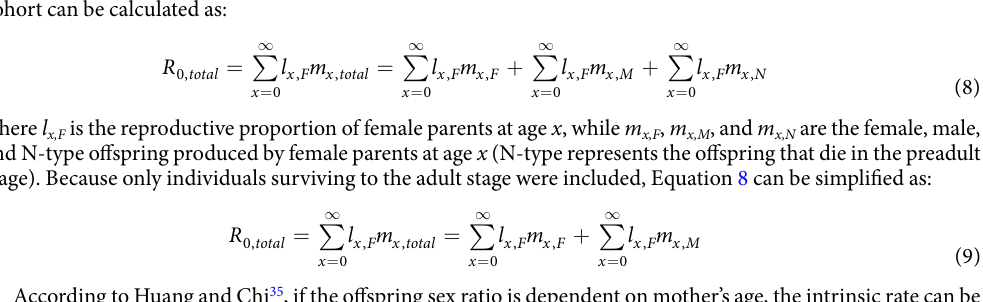
In arrhenotokous reproduction, the offspring sex ratio varies with the age of the female. To determine the effect of offspring sex ratio on the population parameters, we also analyzed the data using the age-stage, two-sex life table method with the offspring sex ratio dependent on female age 35,41 . The net reproductive rate of the parent cohort can be calculated as: